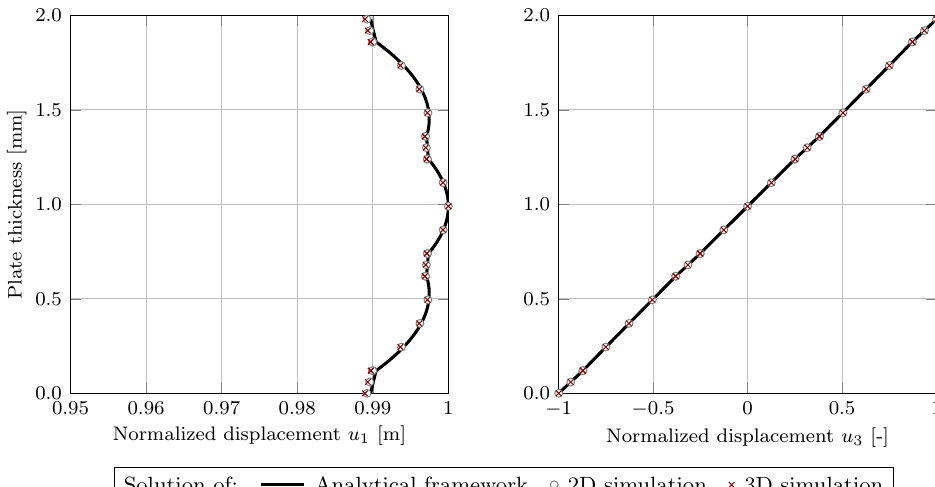
Figure 9. In-plane (left ) and out-of-plane ( right ) components of normalized displacement field for S 0 wave modes perpendicular to the fiber orientation at 80kHz from analytical treatment and numerical 2D- and